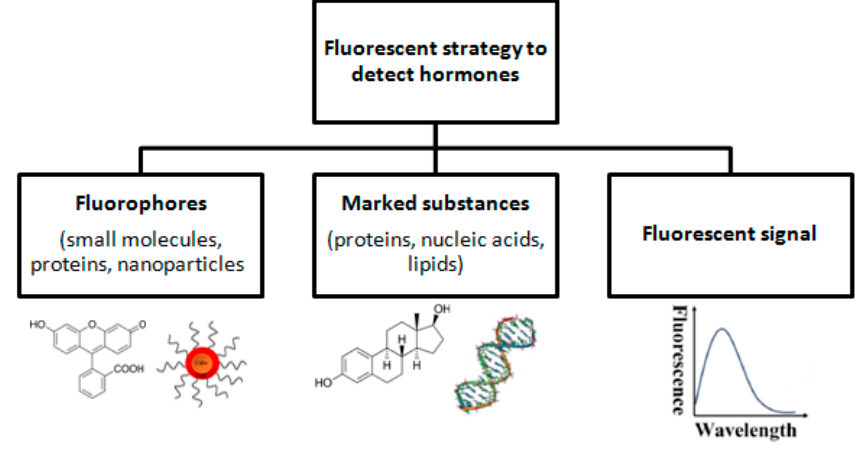
Figure 1. Fluorescent strategy to detect hormones.